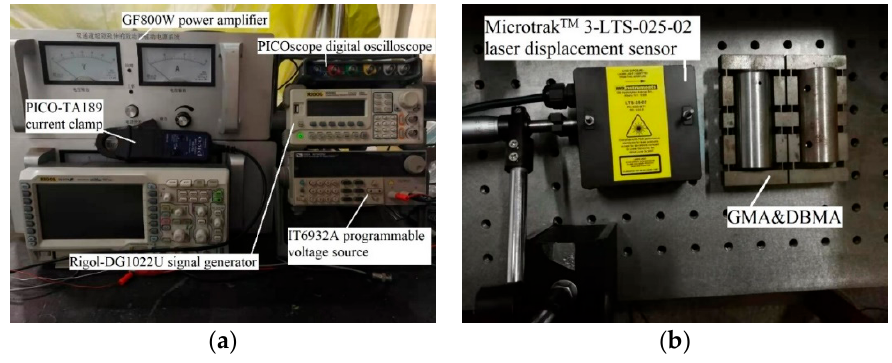
Figure 16. Test System. ( a ) Monitoring part of the test system, ( b ) Measuring part of the test